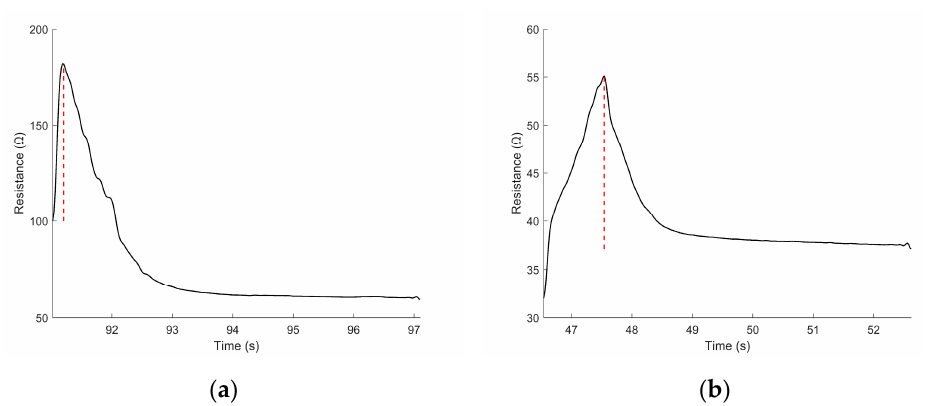
Figure 6. The sensor electrical response following ( a ) an incremental strain step of 0.5 mm and ( b ) following an incremental relaxation step of 0.5 mm. The solid black lines indicate the sensor resistance. The dotted red lines indicate the peak of the resistance spike during the transition between strains. Table 4. The spike magnitude, 𝑆 (in units of Ω/Ω ), was found to be dependent on strain rate. At higher strain rates, the magnitude of the resistance spikes increased. Note that at low strains, the spike magnitudes are significantly smaller, most likely due to sensor buckling.